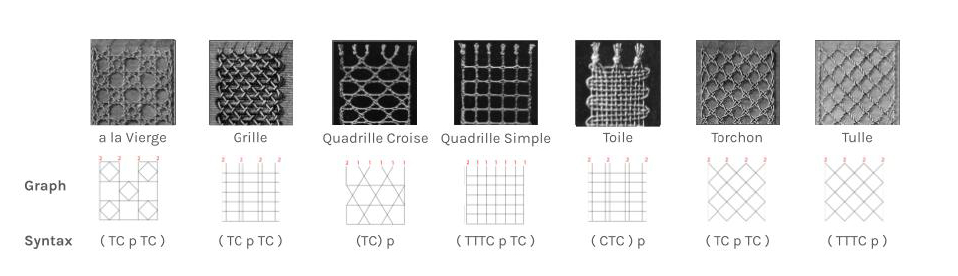
Figure 4. A variety of bobbin lace patterns and their associated graph and fabrication syntax.